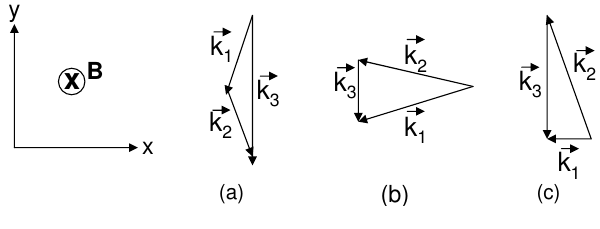
Fig. 13. Possible 3-wave coupling interactions. In (a) two long un- stable waves drive a shorter wave, in (b) two short waves traveling roughly horizontally drive a longer (damped) wave traveling verti- cally, and in (c) a single long unstable horizontal wave drives two damped shorter waves traveling nearly